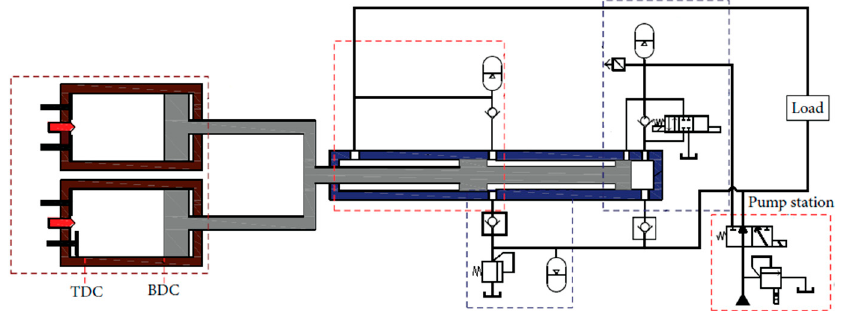
Figure 23. The HFPE of Zhejiang University [60].